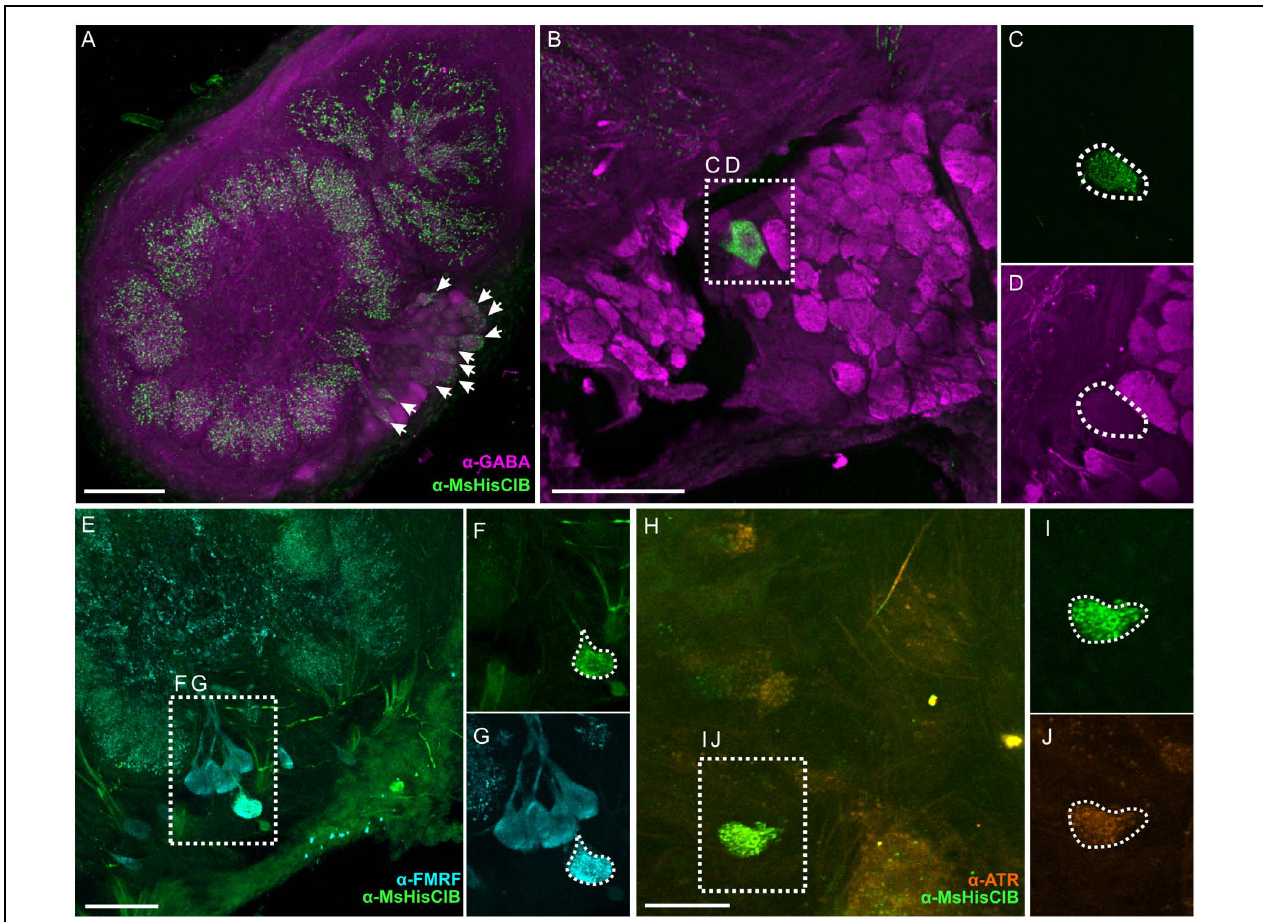
FIGURE 5 | Within the AL the MsHisClB receptor is expressed by a subset of GABAergic LNs and one FMRF-amidergic and one ATRergic LN. (A) MsHisClB (green) and GABA (magenta) co-labeling in the lateral cell cluster of the AL. MsHisClB-ir is expressed in all AL glomeruli. Scale bar 100 μ m. (B) GABA-ir and MsHisClB-ir expression in the lateral cell cluster. (C,D) Inset from (B) highlights a single large MsHisClB-ir cell body that does not express GABA. (E) FMRFamide-ir (cyan) and MsHisClB-ir (green) expression in the lateral cell cluster. (F,G) Inset from (E) highlights a single large cell body that expresses both MsHisClB-ir and FMRFamide-ir. (H) ATR-ir (orange) and MsHisClB-ir (green) expression in the lateral cell cluster. (I,J) Inset from (H) highlights a single large cell body that expresses both MsHisClB-ir and FMRFamide-ir. All scale bars = 50 μ m unless otherwise